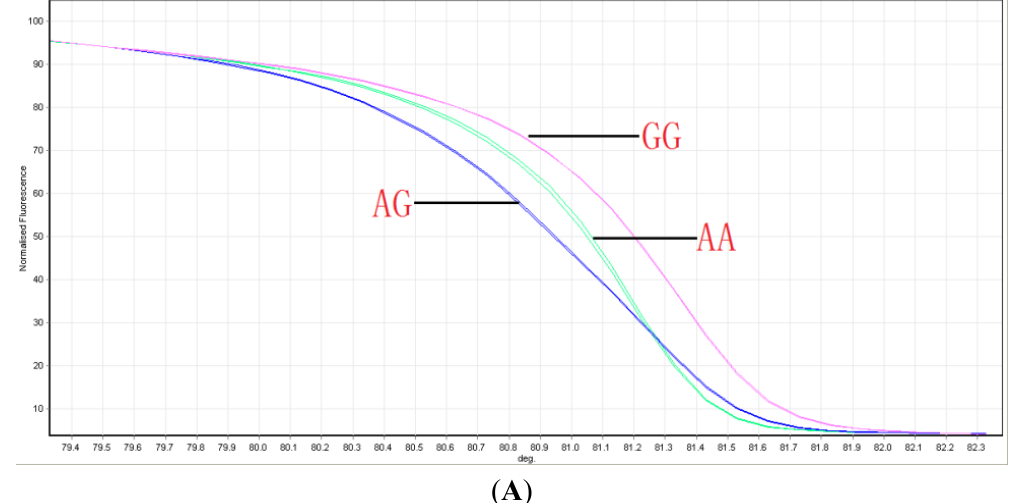
Figure 1. Melting curves of SNP genotypes in the ABCG2 gene. The three groups are